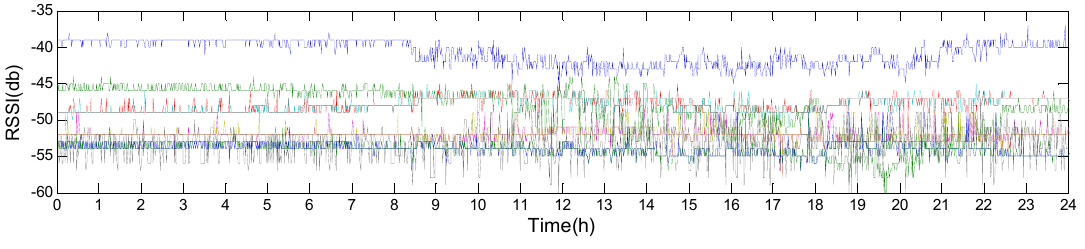
Figure 19. The changes of the RSSIs of the top 10 APs in a day.